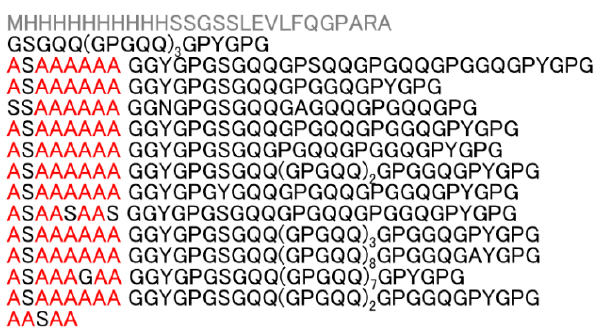
Figure 1. Primary structure of RSP based on the primary sequence of the MaSp2 silk component from the European garden spider, Araneus diadematus . Ala residues are in red; other amino acids, except the His-tag, are in black.